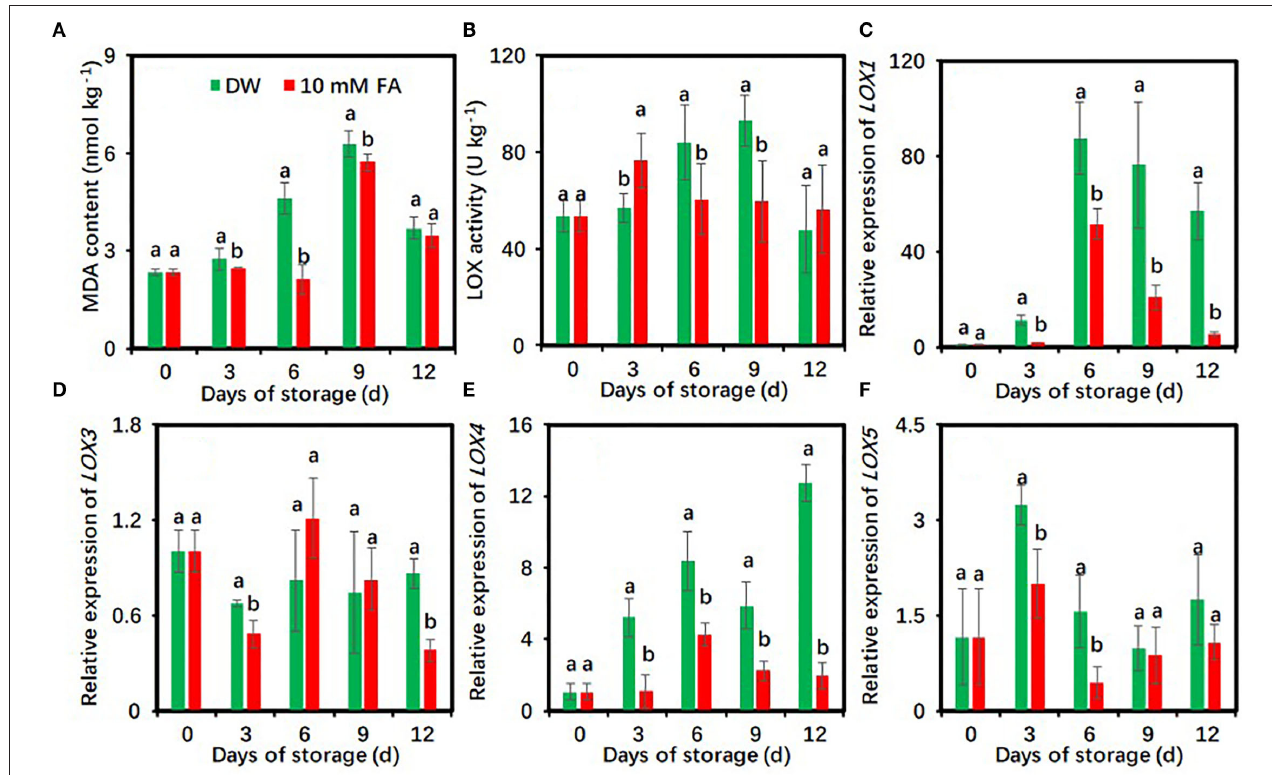
FIGURE 6 | Effects of 10mM FA treatment on malondialdehyde contents (A) and the activity and gene expression of LOX (B–F) in taro slices during storage at 5 ◦ C. Each value is presented as means ± standard deviation (SD, n = 3). Statistical differences ( p ≤ 0.05) between the control and 10mM FA treatment at the same time point are analyzed and indicated using different letters above the